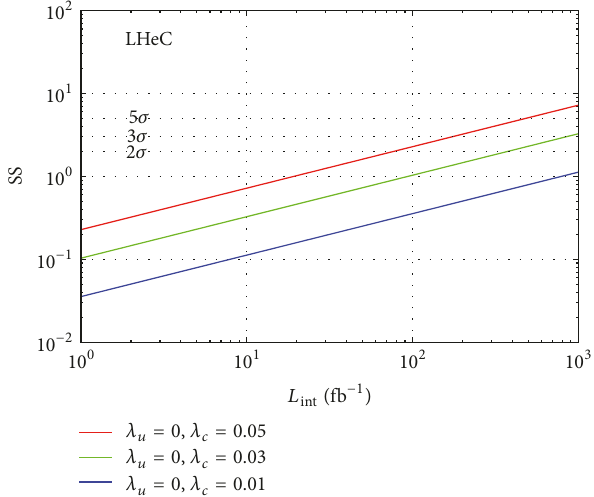
Figure 10: Estimated statistical significance (SS) reach of flavour changing neutral current 𝑡𝑐𝛾 coupling ( 𝜆 𝑐 ) depending on the integrated luminosity ranging from 1fb −1 to 1ab −1 at the LHeC. It includes the contribution from the main background ( 𝐵1 ) on the predicted results. The signal significance corresponding to 2𝜎 , 3𝜎 , and 5𝜎 lines is also